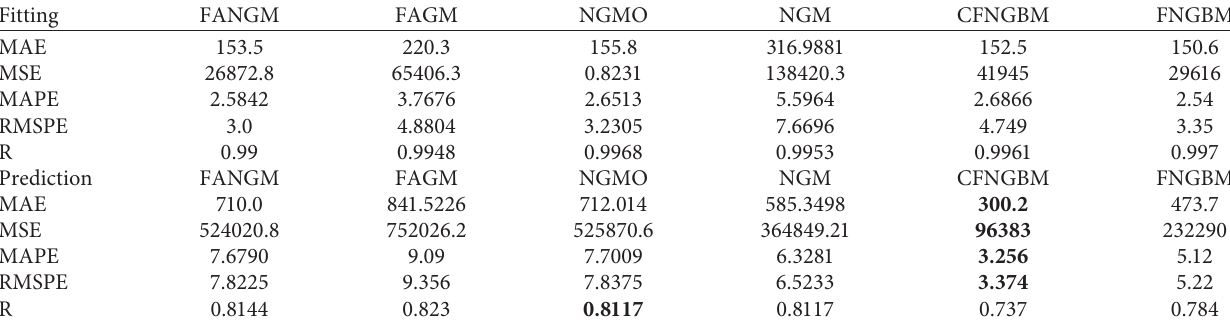
Table 5: Error metrics of CO